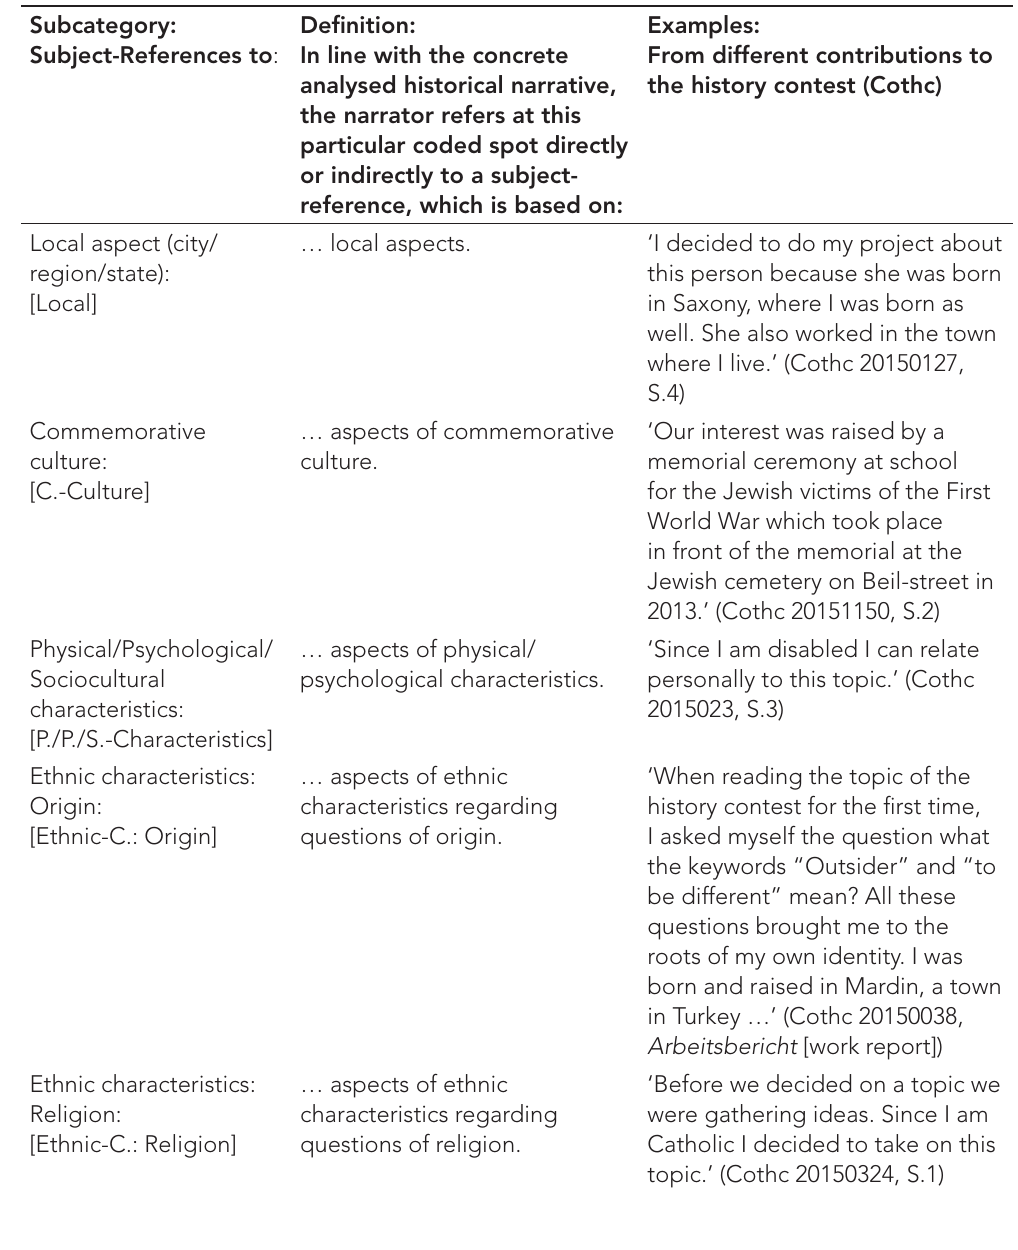
Table 2: Category: subject-references plus related subcategories